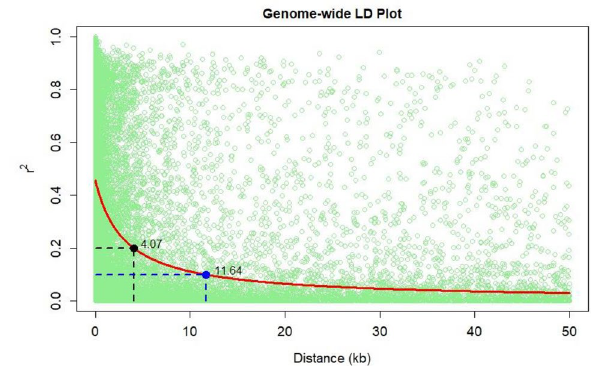
Figure 2. LD decay for the association mapping panel at r 2 = 0.1 and 0.2.